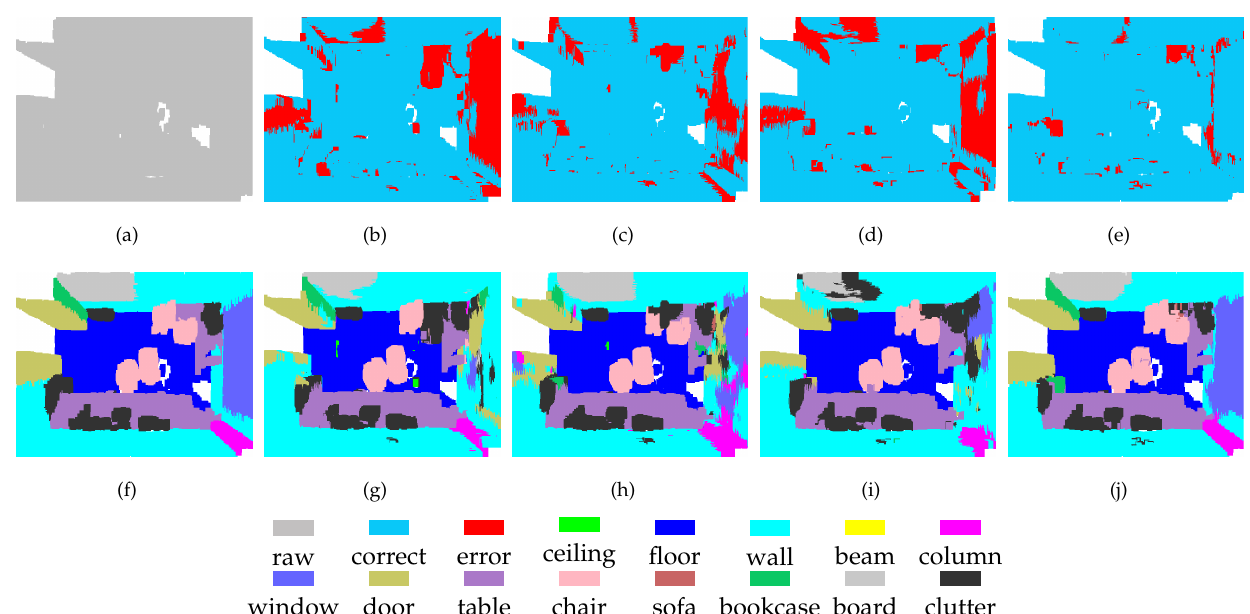
Figure 4. Segmentation results on the S3DIS-1 dataset: ( a ) input, ( f ) ground truth, ( b , g ) PointNet++ , ( c , h ) PointSIFT, ( d , i ) SAN, and ( e , j ) MSSCN.